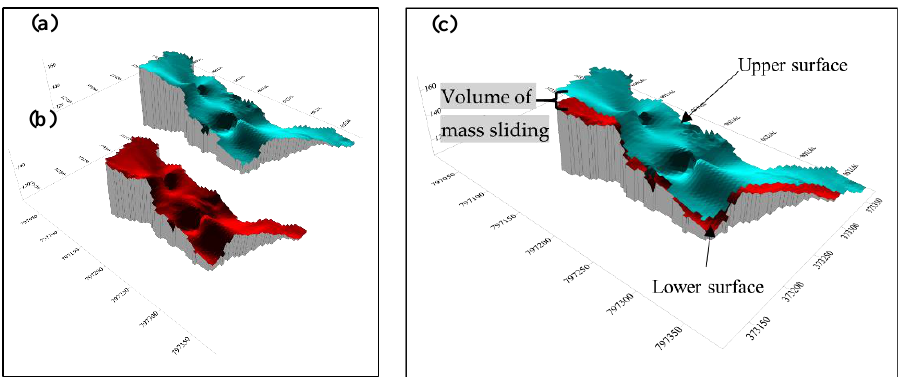
Figure 13. The elevation map of Hulu Yam study areas: ( a ) surface elevation map of the study area; ( b ) extracted surface elevation of landslide area; ( c ) extracted lower surface of failure plane at landslide area.